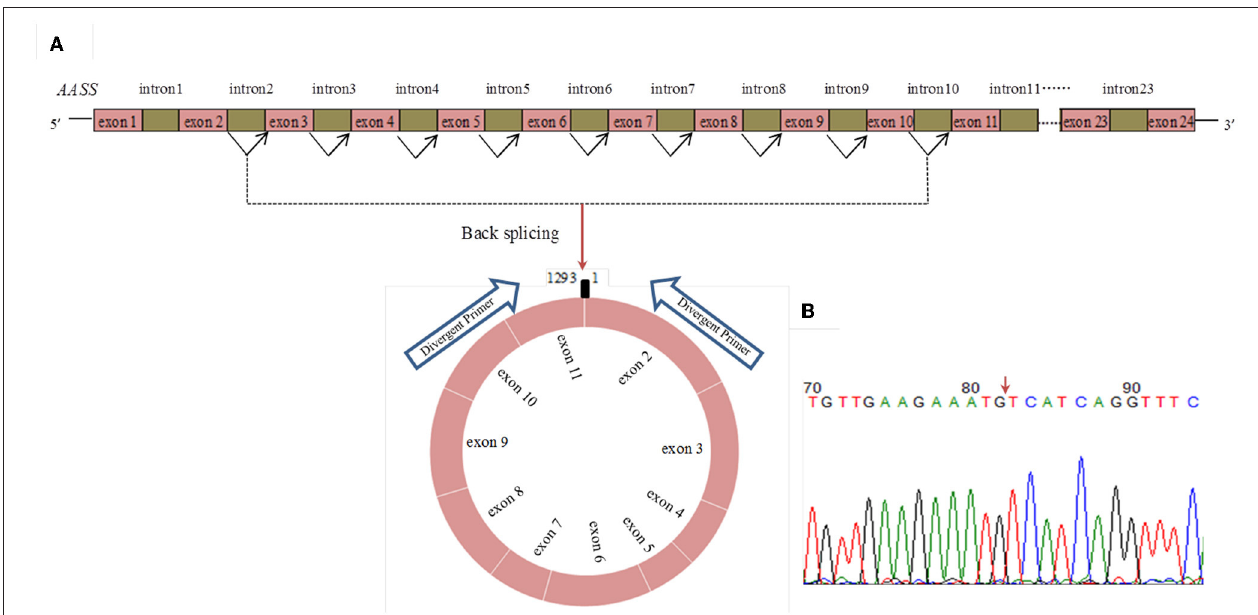
FIGURE 1 | The genomic loci of circ_015343 derived from AASS (A) and verification of head-to-tail splice junction of circ_015343 by using Sanger sequencing (B) . A red arrow indicates the head-to-tail splice junction of circ_015343.